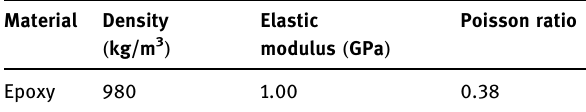
Table 3: Mechanical characteristics of epoxy resin Material Density ( kg/m 3 )